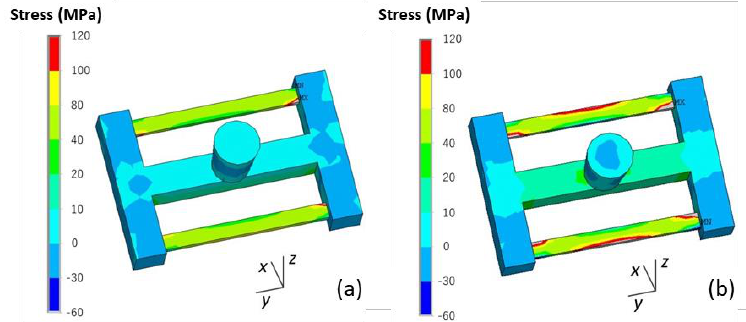
Figure 16. Comparison of the σ y of the castings using the ( a ) skeletal sand mold and ( b ) traditional sand mold at the